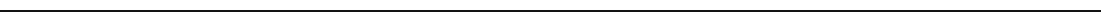
(See figure on previous page.) Fig. 9 Mass accumulation rates (MARs) of some selected materials. a Calculated MAR of marine organic carbon. Gray plots are calculation for individual samples, and black bold lines indicate the average values of the interval between two age controlling points. b Calculated MAR of terrestrial organic carbon. Gray plots are calculation for individual samples, and black bold lines indicate the average values of the interval between two age controlling points. c Calculated MAR of biogenic carbonate. Gray plots are calculation for individual samples, and black bold lines indicate the average values of the interval between two age controlling points. d Calculated MAR of terrigenous material. Gray plots are calculation for individual samples, and black bold lines indicate the average values of the interval between two age controlling points. e High- resolution δ 18 O records from planktonic ( G. bulloides ) and f benthic foraminifers from CbCS (Haneda et al. 2020b). Thick lines are 1000 yr moving average profiles. Dashed lines are Marine Isotope Stage and substage boundaries, based on Haneda et al. (2020b). Yellow shades at ~ 764 and 760 ka highlight Millennial Isotopic Oscillation (MIO)-Interstadial 2 and MIO-Interstadial 3, respectively (Haneda et al. 2020b), which correspond with relatively large variations in TOC and TN values. Black arrows indicate the age controlling points (cf.